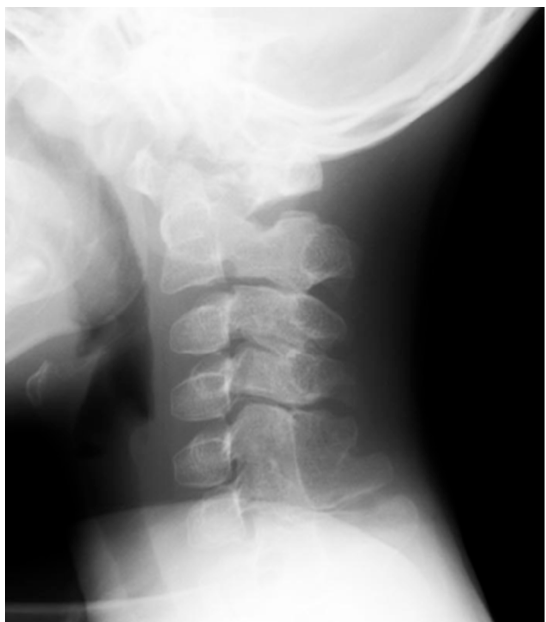
Figure 5. Lateral radiograph of the cervical spine of a FOP boy at the age of 7 years showing hypertrophy of the laminae and spinous processes and complete osseous fusions in facet joints and spinous processes between C5 and C6.